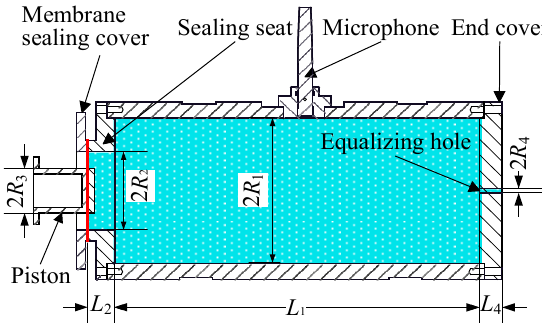
Figure 2. Schematic diagram of the pistonphone chamber. Table 1. Properties of the laser pistonphone.